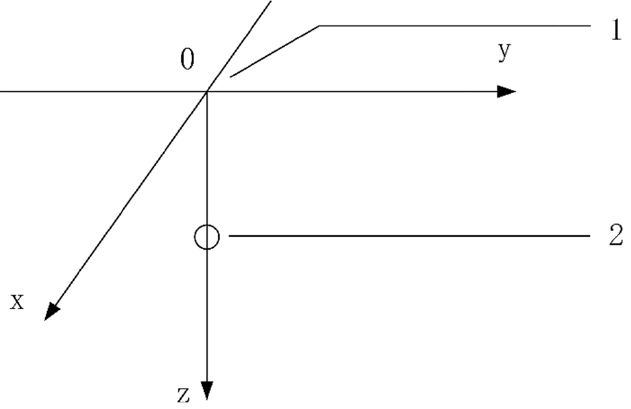
Figure 11. Spatial location of H. cunea 1. Coordinate origin 2. H. cunea position. X, Y, Z are three- dimensional axes.